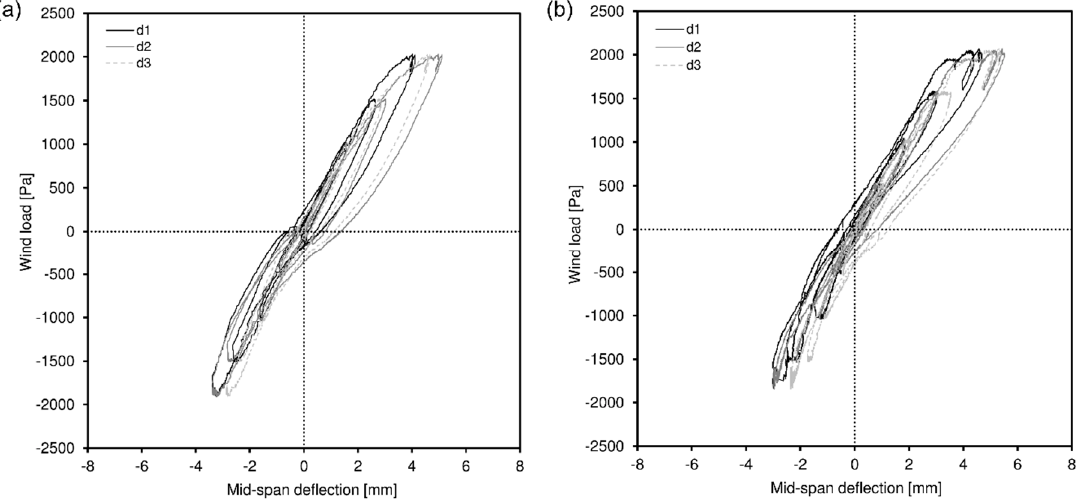
Figure 12. Wind load versus mid-span deflection ( d 1– d 3) for single (S) connectors ( a ) and for double (D) connectors ( b ). The deflection values are adjusted with respect to displacements at the anchors.